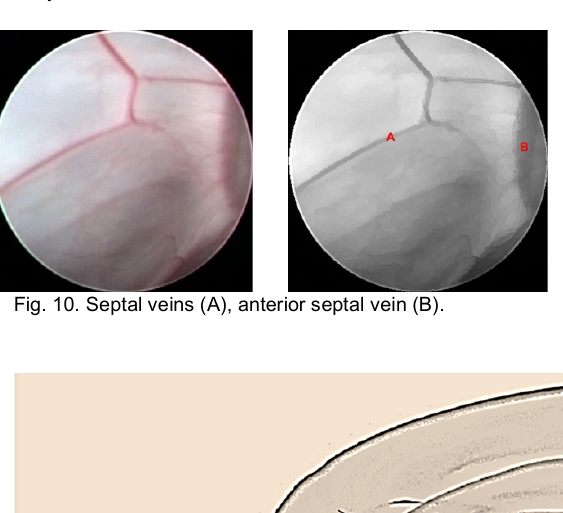
Fig. 9. Direction of the endoscopic viewing angle for ventricular body.